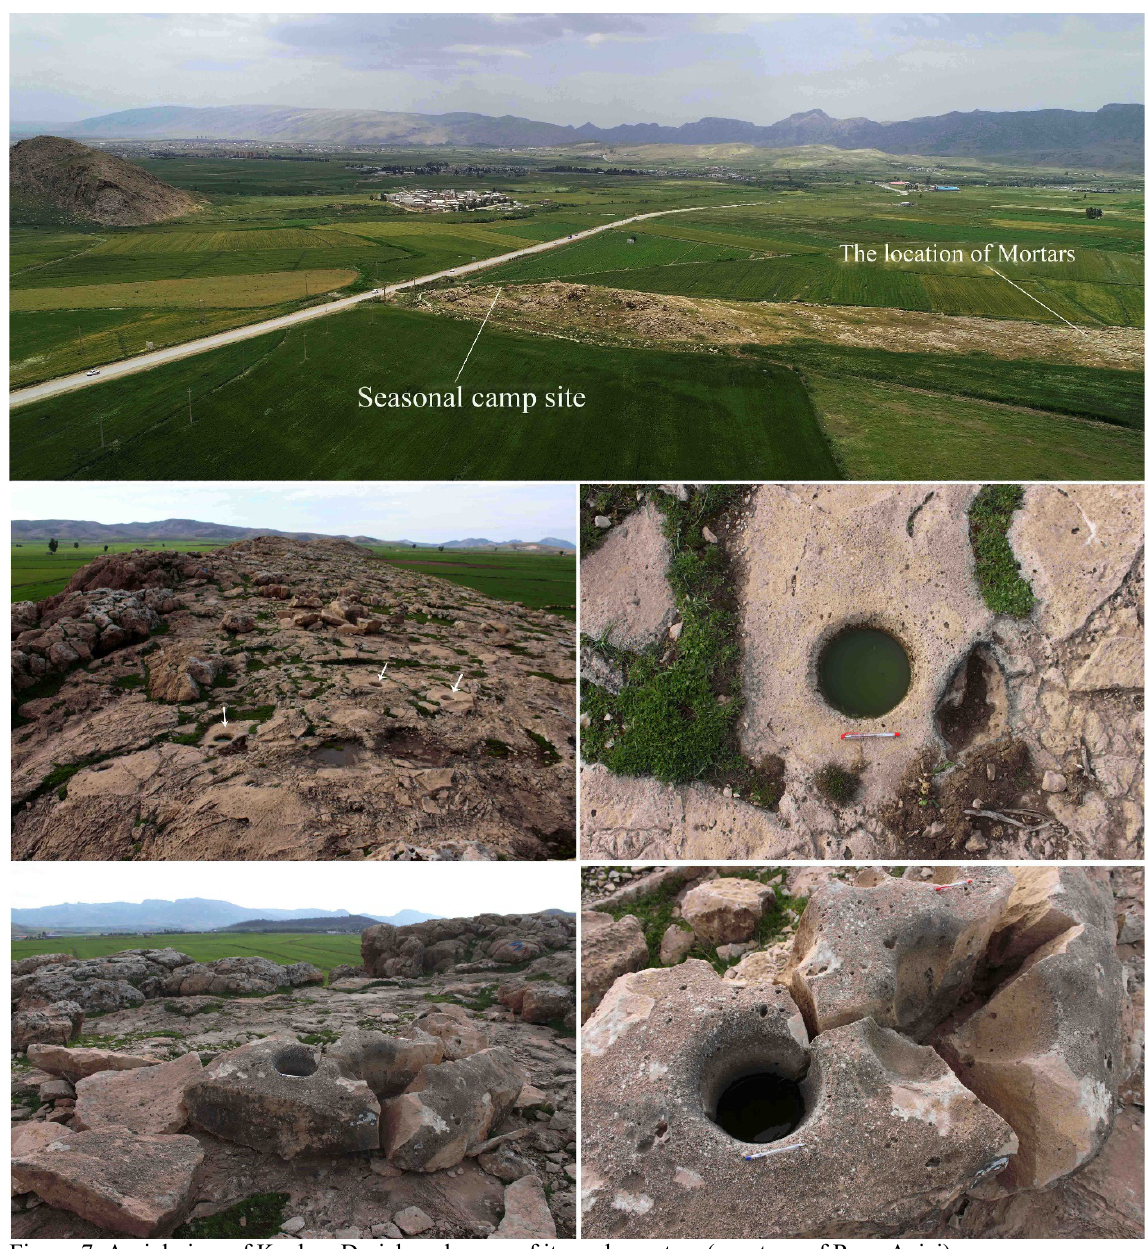
Figure 7. Aerial view of Kucheg Derizh and some of its rock mortars (courtesy of Reza